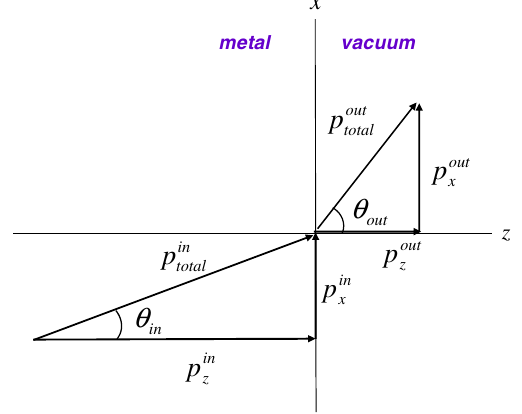
FIG. 3. (Color) Diagram showing the conservation of transverse momentum at the metal-vacuum interface. Outside the surface the maximum angle is (cid:2)= 2 when the electrons are refracted with the largest internal angle of incidence (cid:3) in max . Electrons with angles greater than (cid:3) in max are reflected back into the metal.